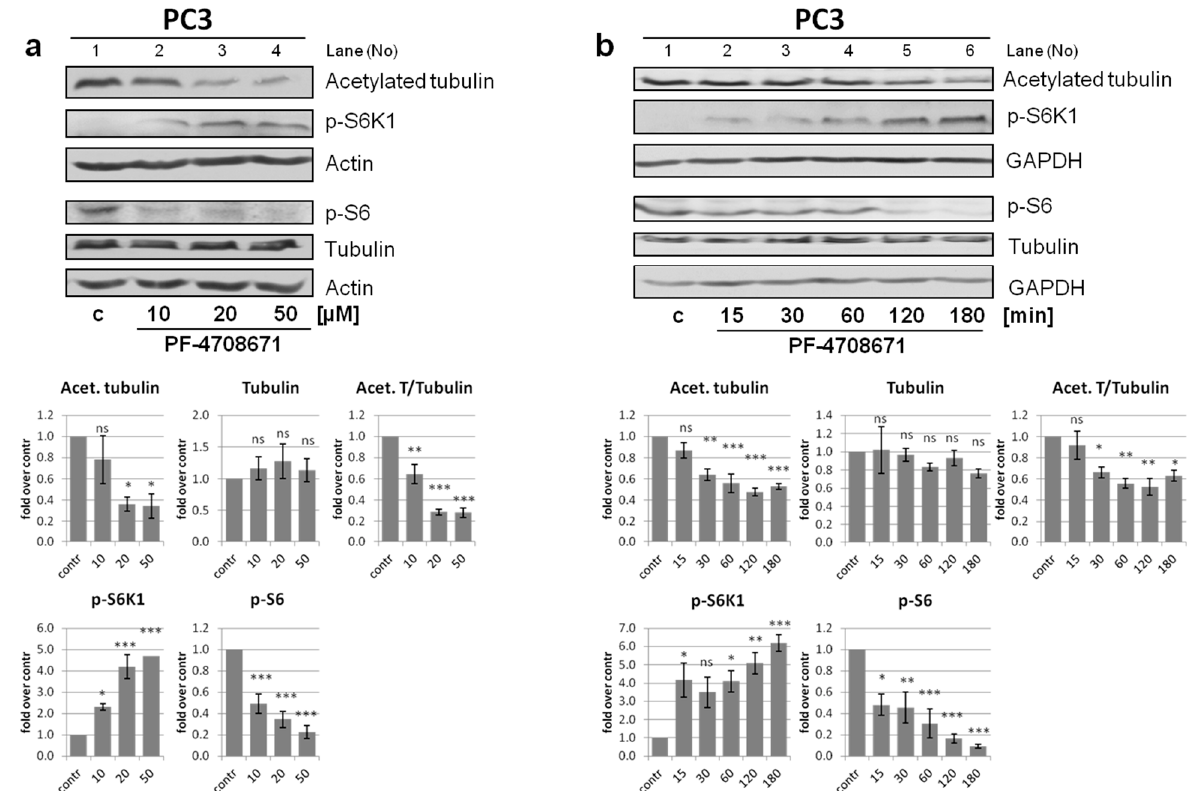
Figure 9. Modulation of tubulin acetylation by S6K1 is dependent on its phosphorylation status. Prostate cancer cells (PC3) were treated ( a ) for 3 h with the indicated concentrations of PF-4708671, or ( b ) with 10 µM PF-4708671 for the indicated time periods. The control cells ( c ) were treated with the vehicle (DMSO). Acetylated tubulin, tubulin, p-S6K1 (Thr389), and p-S6 protein levels were evaluated by western blotting. The blots were re-probed with anti- β -actin or anti-GAPDH antibodies to ensure equal protein loading. Graphs below immunoblots show densitometric data, corrected for loading control and presented as a fold-change from the reference (control; line 1 ). The experiments were performed in three independent replicates and representative blots are shown. The data are shown as the mean ± SEM. The statistical significance of differences between control and treated cells was determined by one-way ANOVA followed by Dunnett’s multiple comparison test: * p < 0.05, ** p < 0.01, *** p < 0.001; ns, not significant.